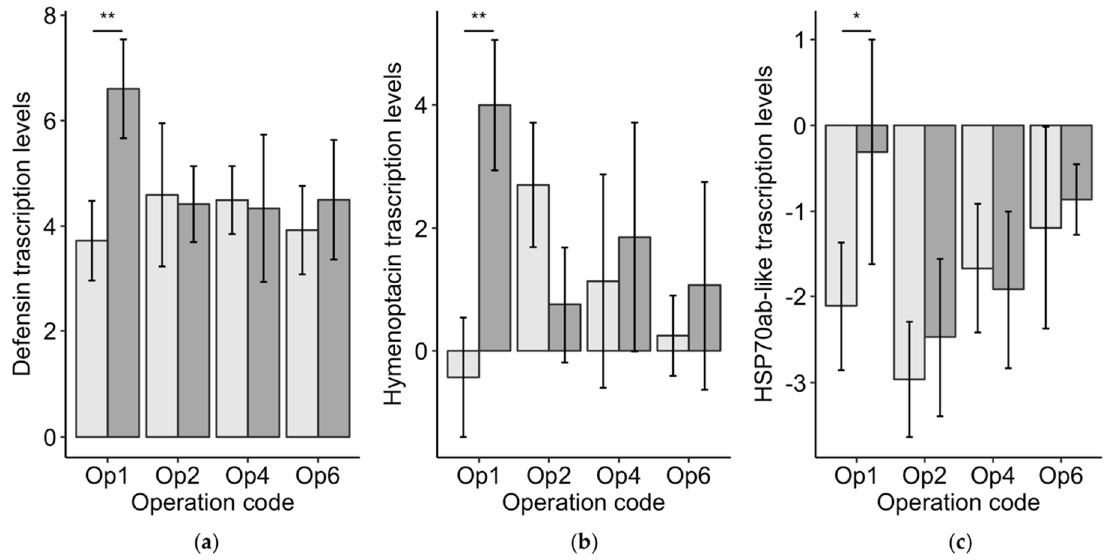
Figure 3. The transcription levels (means ± 95% CI)) relative to the reference gene actin for the two immune gene peptides defensin ( a ) and hymenoptacin ( b ), and the heat shock protein HSP70ab-like ( c ). The significance asterisks indicate that the only significant comparisons were between the worker bees from good-brood colonies (light grey) compared poor-brood colonies (dark grey) within Operation 1